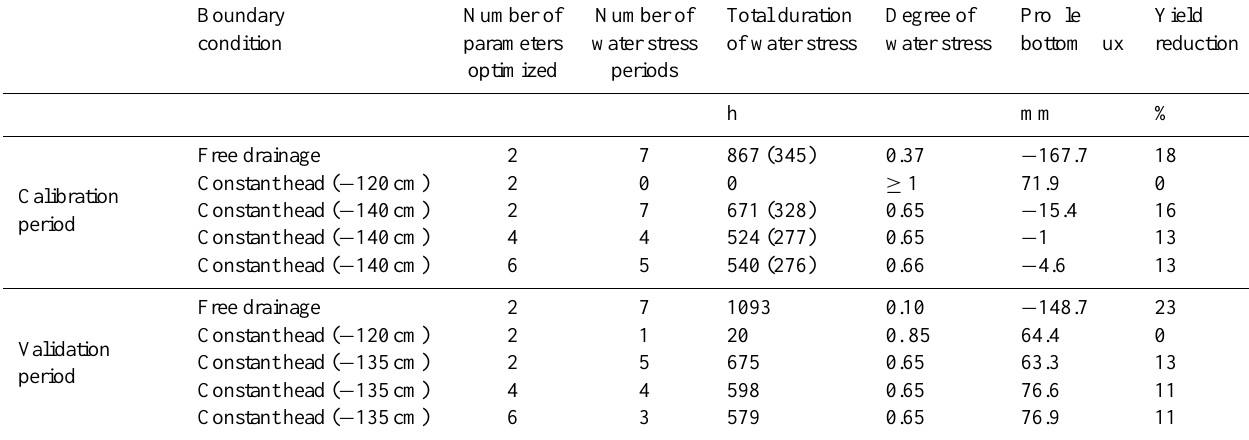
Table 4. Total duration, number and extent of water stress for different boundary conditions and scenarios (from 1 March to 12 Septem- ber). Total rainfall and irrigation amount were 398.2 and 64.5mm in 2012 and 343.3 and 85.4mm in 2013 respectively. Number between parentheses represents the duration of first water stress event due to light-radiation and temperature limitations. Boundary Number of Number of Total duration Degree of Profile Yield condition parameters water stress of water stress water stress bottom flux reduction optimized periods h